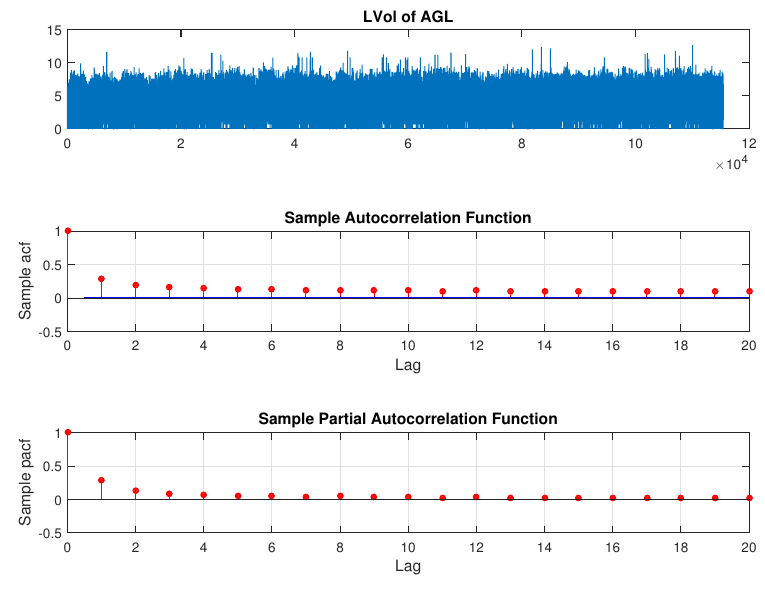
Figure 1. Time series, acf and pacf for LVol of